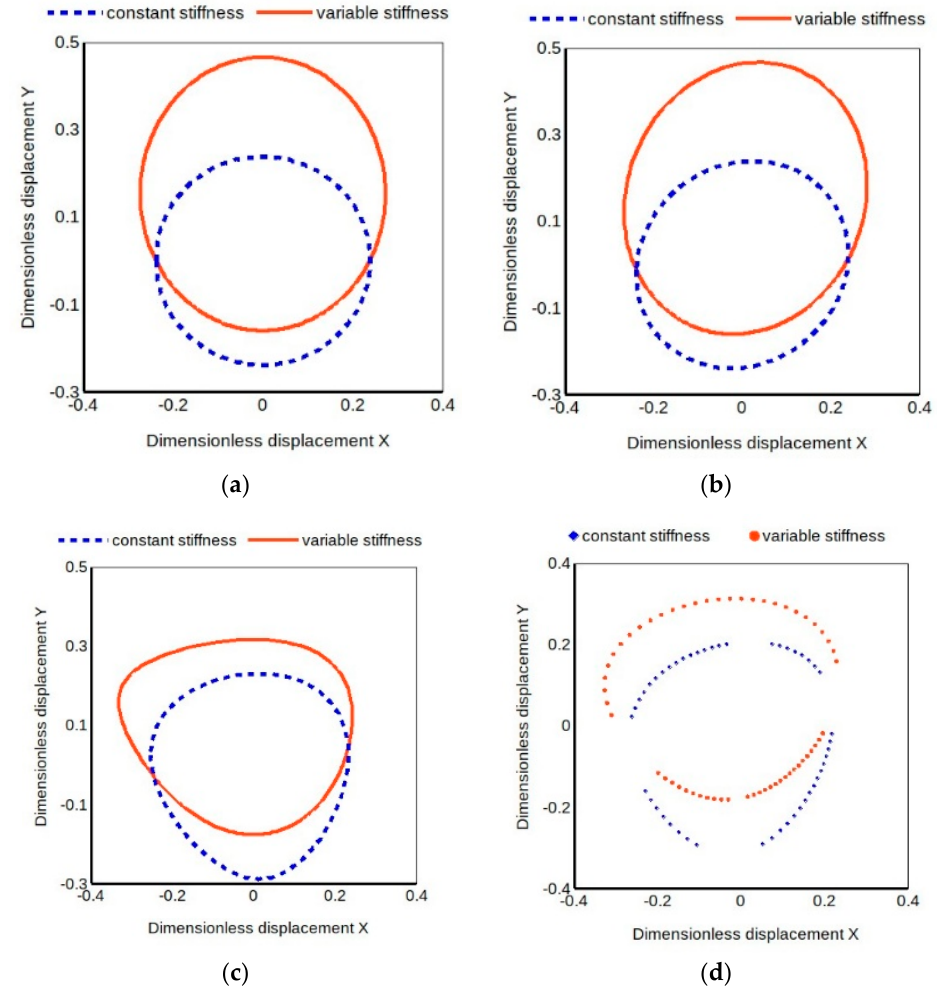
Figure 6. Calculated orbits for the four-pad TPJB for four di ff erent models: ( a ) linear constant and load dependent direct sti ff ness coe ffi cients only; ( b ) linear constant and load dependent direct and cross-coupled sti ff ness coe ffi cients; ( c ) nonlinear constant and load dependent direct sti ff ness coe ffi cients only; ( d ) nonlinear constant and load dependent direct sti ff ness coe ffi cients with linear constant and load dependent cross-coupled sti ff ness coe ffi cients. Case L1-36%.